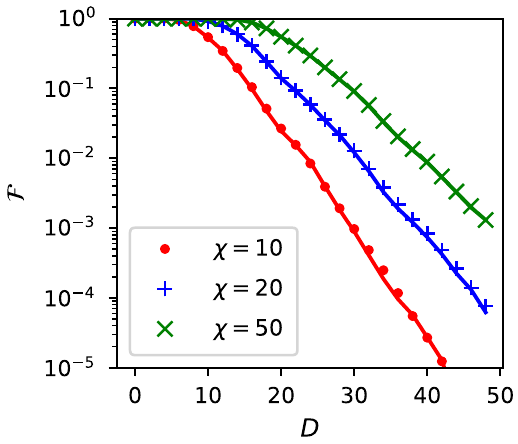
FIG. 6. Geometric average of the fidelity per gate f function of the gate position n . Only an enlargement close to one edge of the MPS is shown. The average is restricted to the regime where the fidelity has reached its asymptotic value ( 100 ≤ D ≤ 200 ); see Fig. 4. A single realization of the circuit has been used, hence the fluctuations. These fluctuations become very small upon further averaging on n as done in Fig. 5.